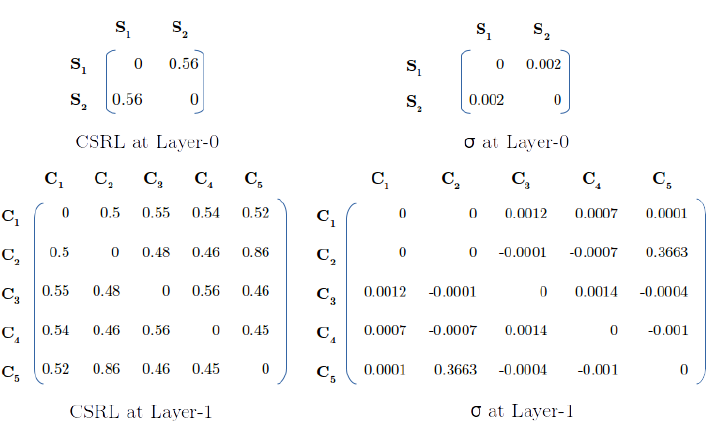
Figure 5. The concept similarity relation learning (CSRL) weight matrices learned with Toy-data and their corresponding impact dactor ( σ ) at layer 0 and layer 1. σ is calculated using Equation